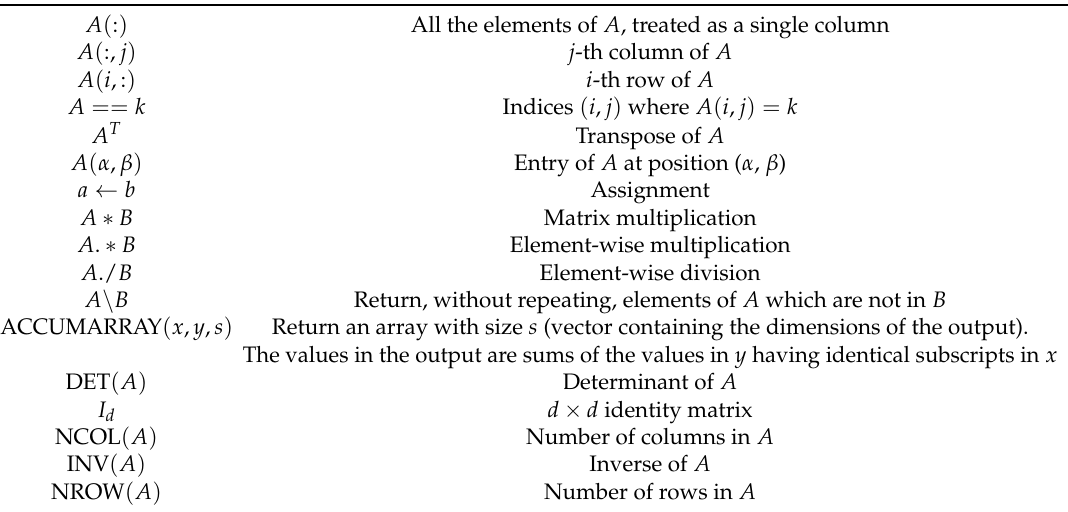
Table 2. Some common functions and